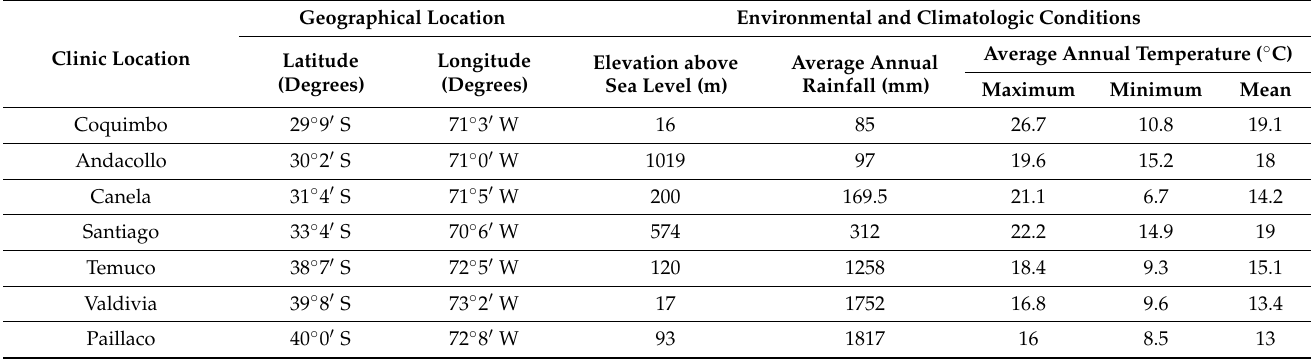
Table 3. Geographic, environmental and climatologic conditions for each of the study locations in